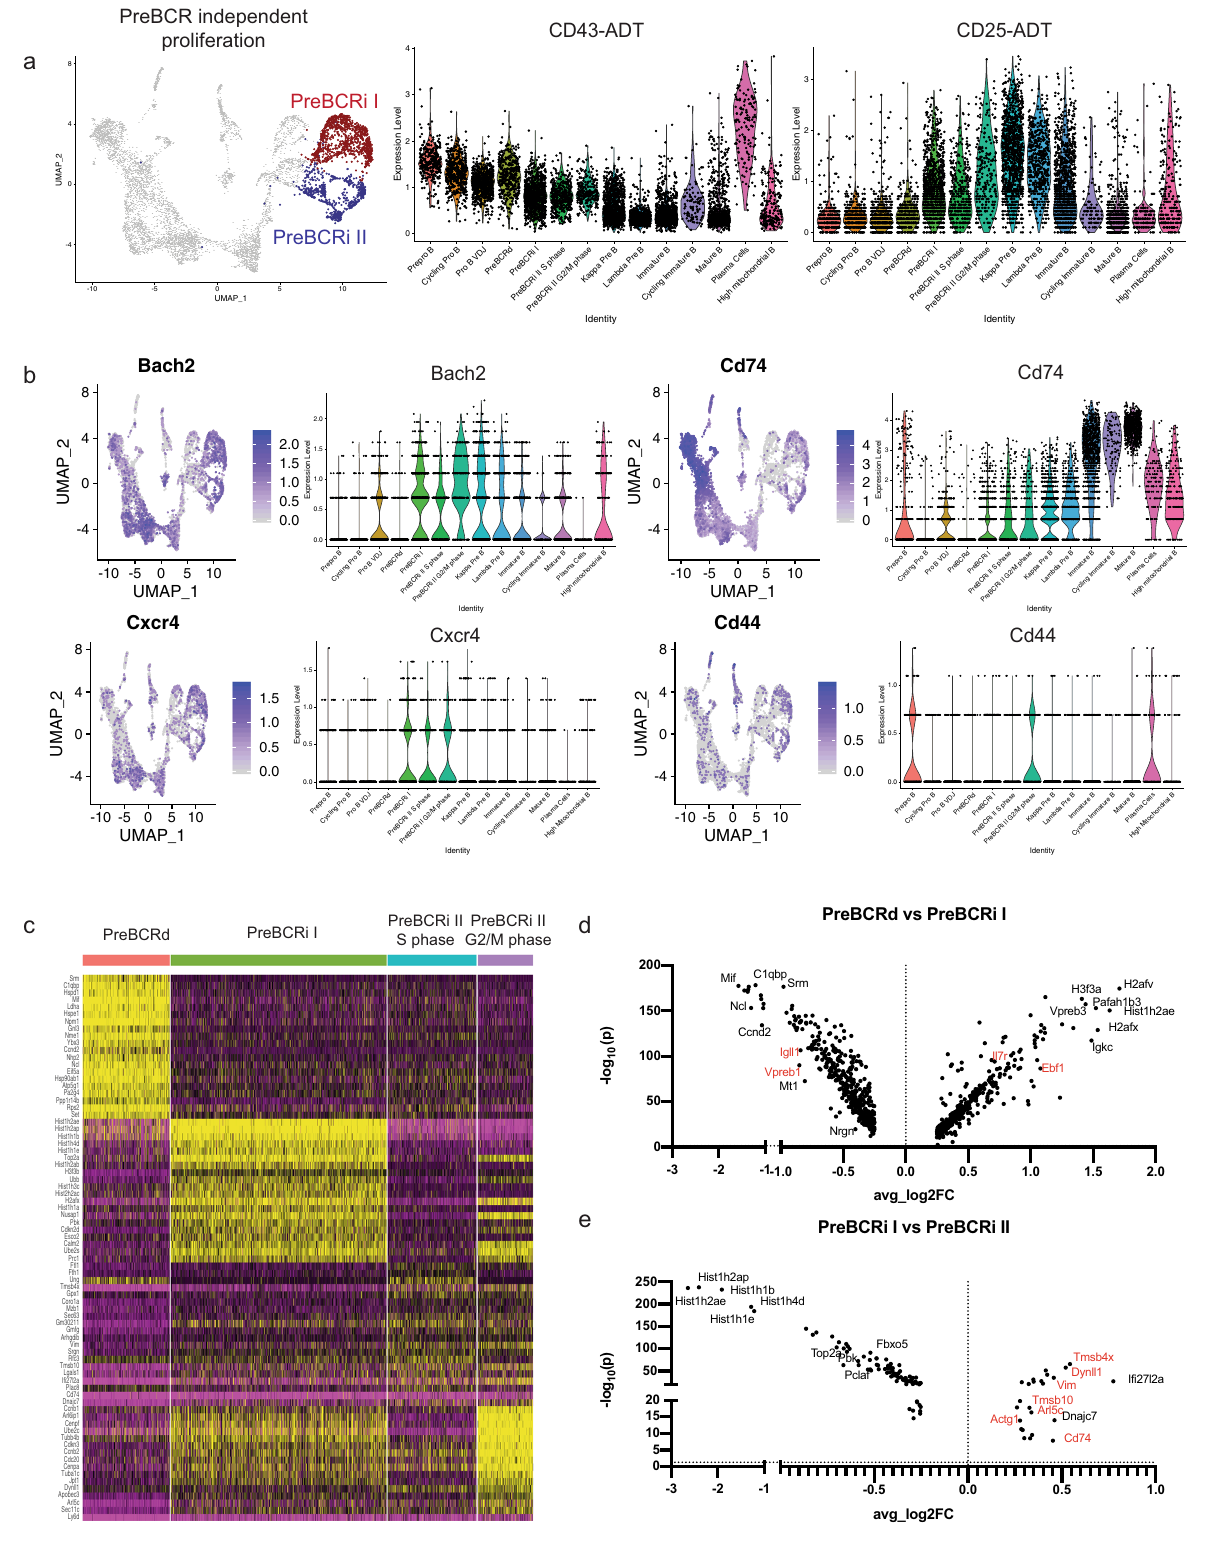
Fig. 4 Pre-BCR-independent proliferation is distinct from pre-BCR-dependent proliferation. a Highlighted pre-BCRi I and pre-BCRi II populations (left). Violin plots of expression of ADT-CD43 and ADT-CD25 across the B-cell development stages (right). b Feature plot and violin plot for Cd74 , Cd44 , and Bach2 . c Heatmap of differentially expressed genes between the pre-BCR-dependent (Pre-BCRd), pre-BCR-independent I (Pre-BCRi I), and pre-BCR- independent II (Pre-BCRi II) S, or G2/M phase. Scale represents normalized counts centered and scaled across cells. d Volcano plot showing differentially regulated genes between the pre-BCRd cluster and the pre-BCRi I cluster. e Differentially regulated genes between the pre-BCRi I cluster and the pre-BCRi II cluster. Color scales in a, b represent natural log-transformed SCTransform-corrected